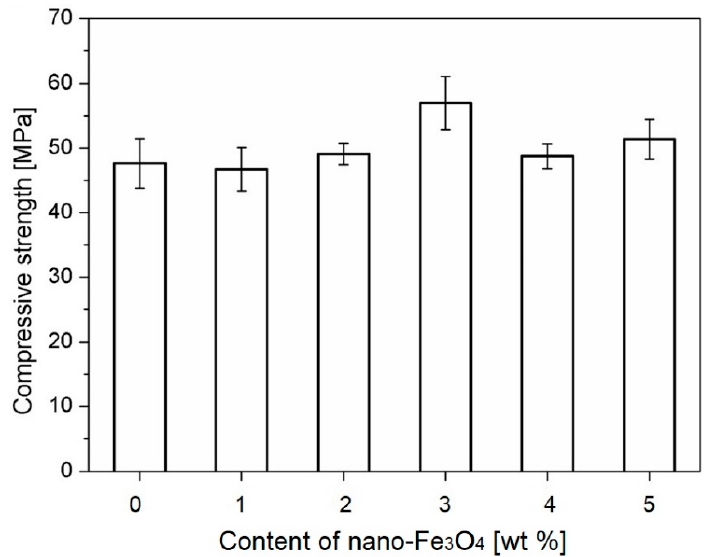
Figure 17. The compressive strength of cement mortars containing nano-Fe 3 O 4 after 28 days of curing (Reprinted with permission from [40]).